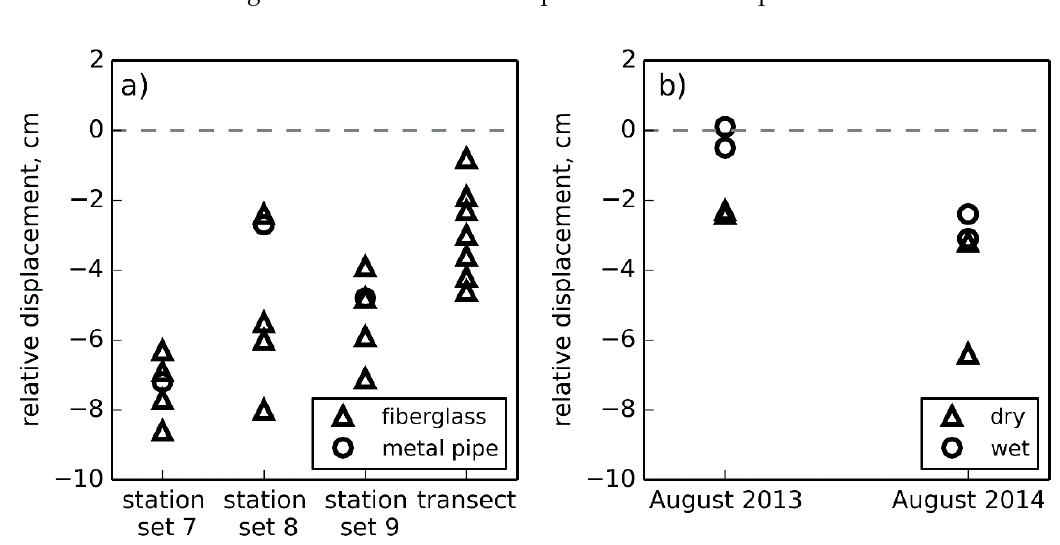
Figure 5. ( a ) Spatial variability of seasonal subsidence measured in late August 2014 (relative to April 2014) on different scales: station sets 7, 8, and 9 are spaced 1 m or 0.5 m within each group, and the transect consists of seven stations spaced about 25 m from each other; ( b ) Seasonal subsidence measured in August 2013 and August 2014 at four sites; two were dry (mid-1 and south-1), and two were wet (mid-2 and south-2).